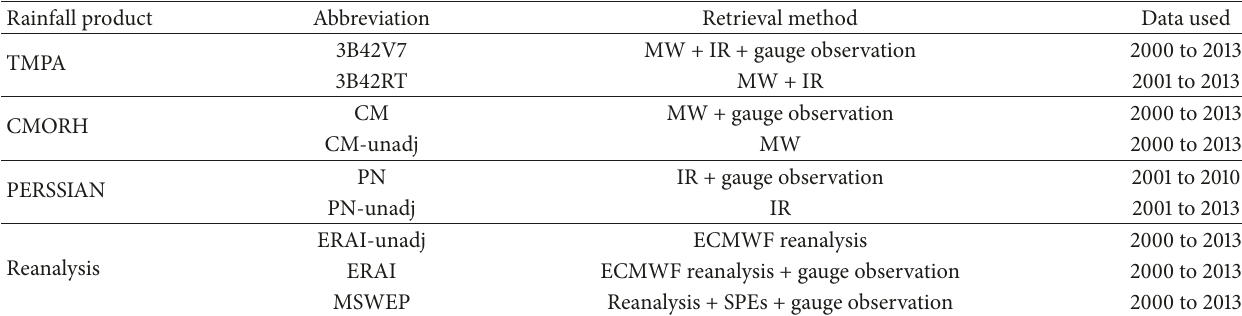
Table 1: Summary of the satellite-based and reanalysis rainfall products used in this